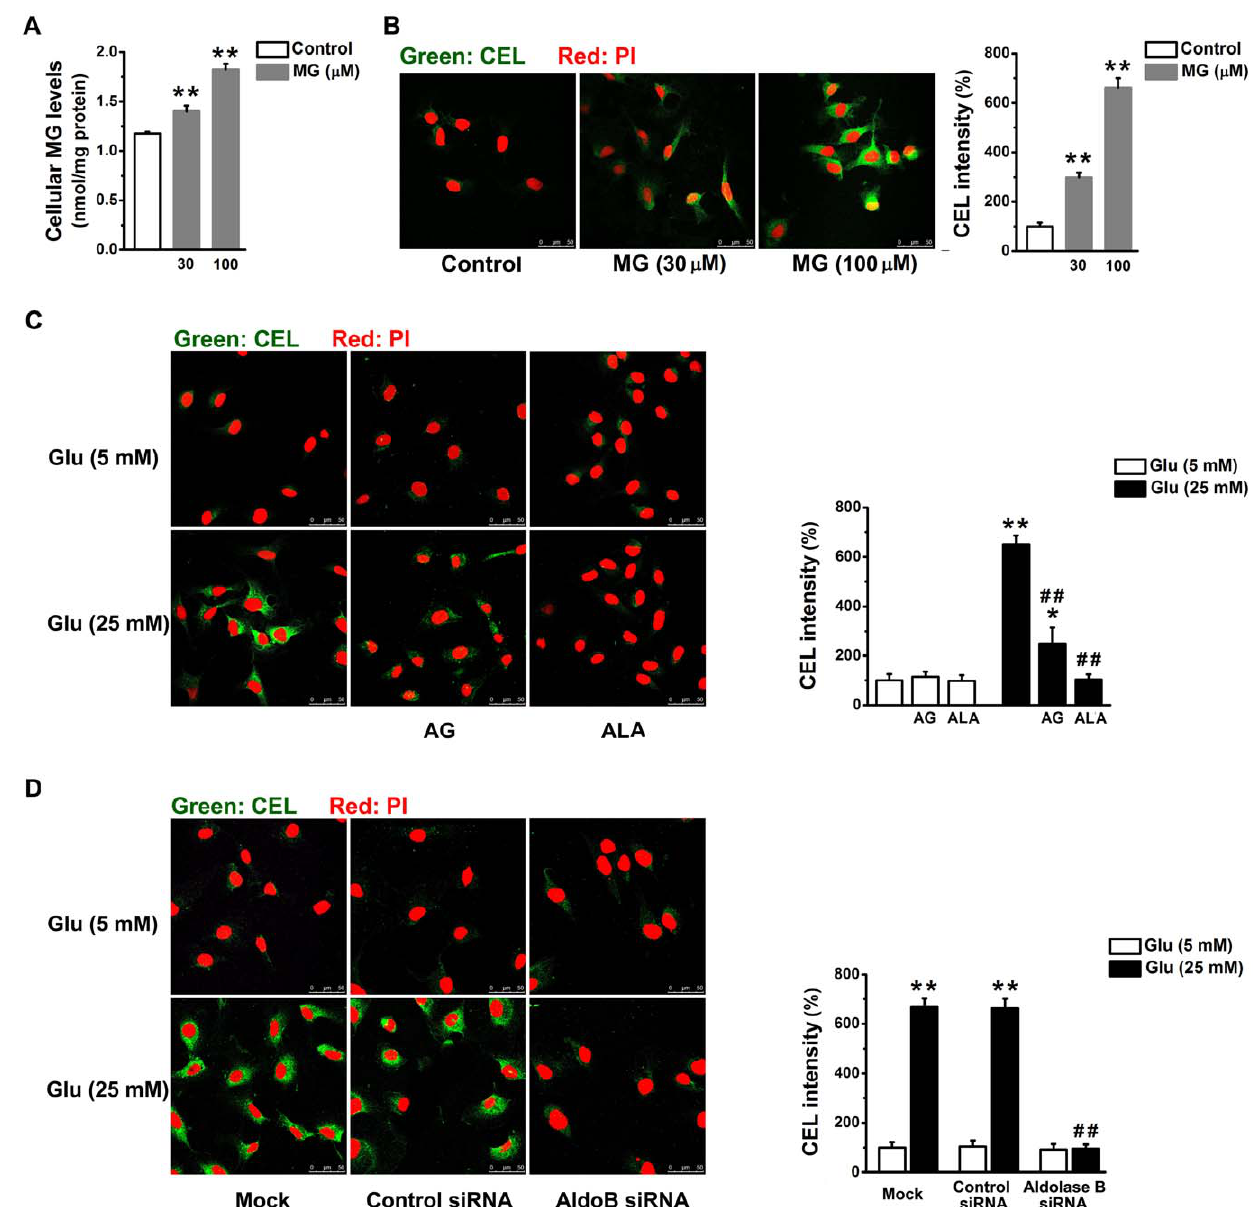
Figure 2. Knockdown of aldolase B prevented AGEs overproduction in high glucose-treated EA. hy926 cells. Levels of MG (A) and N( e )- carboxyethyl-lysine (CEL) in green (B) in cells treated with exogenous MG for 3 days. ** P , 0.01 vs . control (5 mM glucose). (C) CEL levels in cells treated with glucose (Glu) in the presence or absence of aminoguanidine (AG, 1 mM) and alagebrium (ALA, 100 m M) for 3 days. * P , 0.05, ** P , 0.01 vs . 5 mM glucose; ## P , 0.01 vs . 25 mM glucose. (D) CEL levels in cells transfected with control or aldolase B siRNA, or only transfection agent (mock). ** P , 0.01 vs . 5 mM glucose; ## P , 0.01 vs . control siRNA. Nuclear DNA (red) was stained with propidium iodide (PI). The summary of fluorescence intensity of CEL was measured using Image